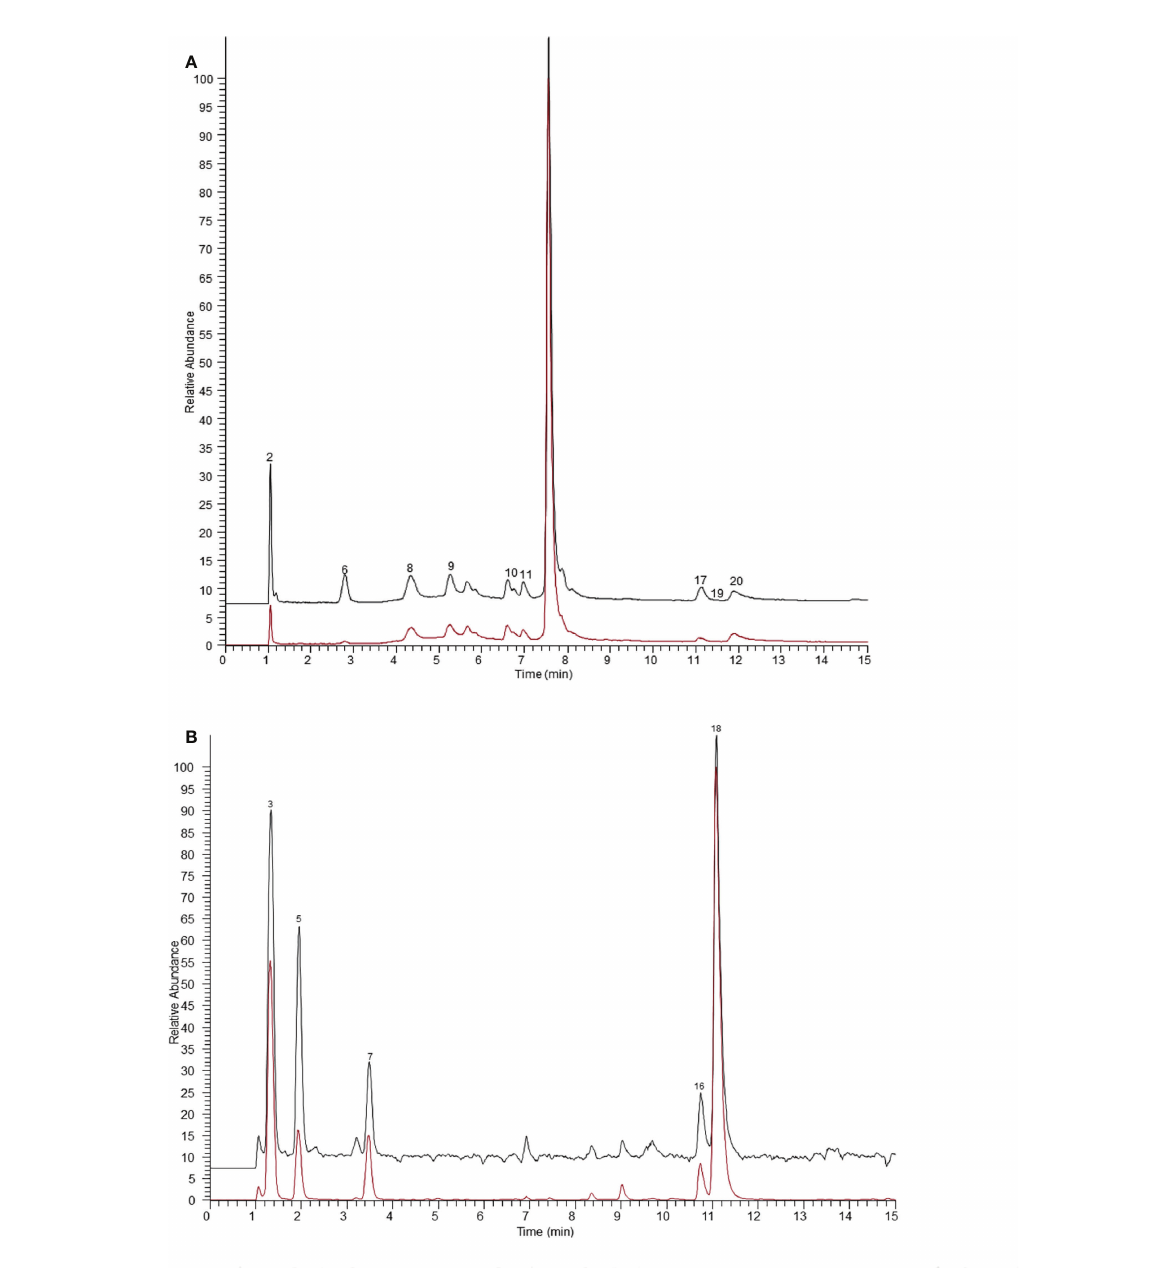
FIGURE 1 The ultra fi ltration UHPLC-Q-Exactive Orbitrap MS chromatograms of the potential ER a ligands in Arnebiae Radix . (A) Extracted ion chromatograms of compounds bound to ER a in negative ion mode. (B) Extracted ion chromatograms of compounds bound to ER a in positive ion mode. The black line represents active ER a group, the red line represents denatured ER a